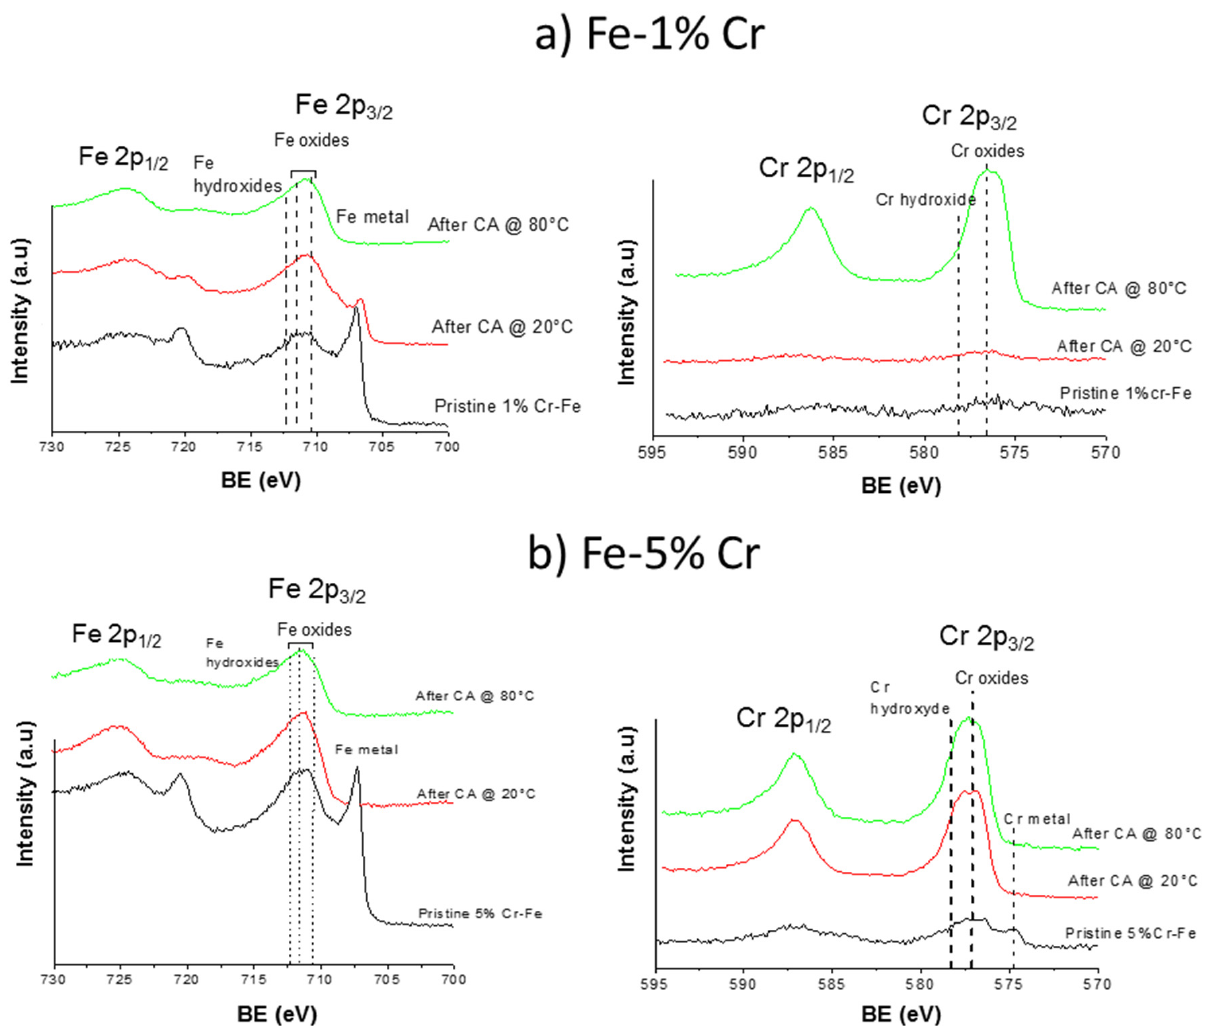
Figure 9. Comparison of Fe 2p and Cr 2p spectra for Fe-1% Cr ( a ) and Fe-5% Cr ( b ) performed for pristine samples and after chronoamperometric measurements in passive region at 20 °C and 80 °C.